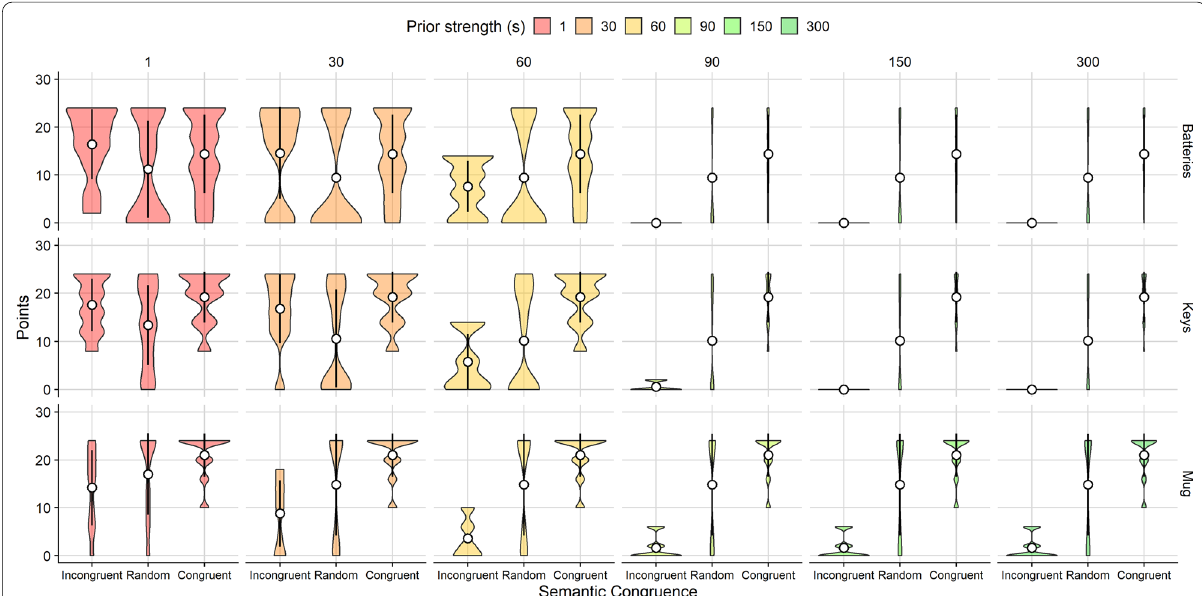
Fig. 7 Violin plots showing points earned by the ideal observer for 3 targets (rows) for different levels of prior strength (columns), as a function of semantic congruence. Low values for prior strength simulated a strong reliance on recent experience, while high values simulated a strong reliance on prior beliefs. Each violin plot corresponds to N 500 simulated trials. White circles indicate the mean and error bars represent ± 1 standard = deviation